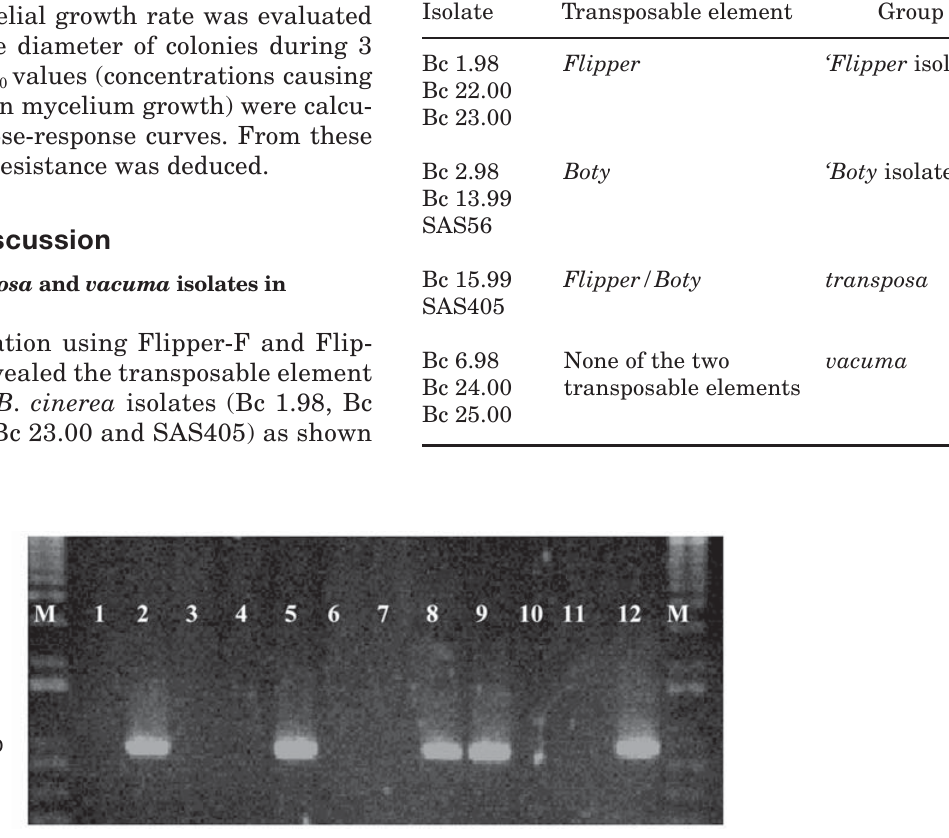
Fig. 1. Electrophoresis on 1% agarose gel showing the result of the Flipper PCR amplification. Lane 1, SAS56; lane 2, SAS405; lane 3, Bc 2.98; lane 4, Bc 13.99; lane 5, Bc 1.98; lane 6, Bc 6.98; lane 7, Bc 24.00; lane 8, Bc 22.00; lane 9, Bc 23.00; lane 10, Bc 25.00; lane 11, Bc 15.99; lane 12, Bc 22.00; M, marker, 1 kb DNA ladder.